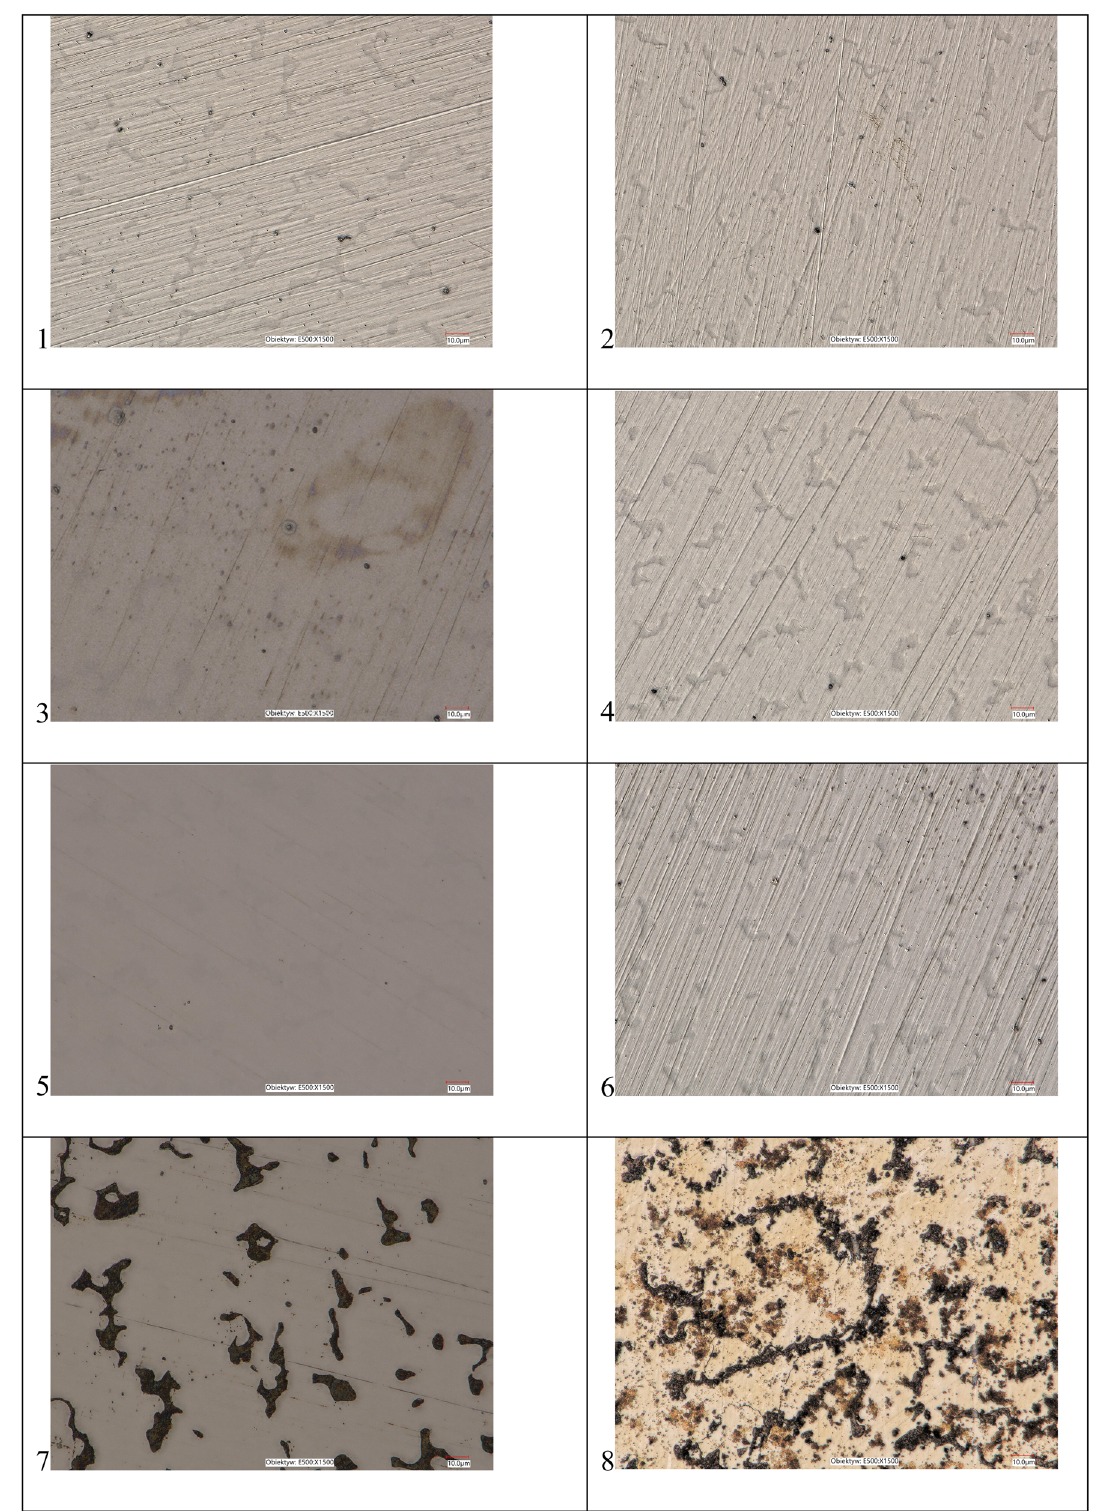
Figure 1: Digital microscopy images of Co – Cr alloy after storage: ( 1 ) dry, ( 2 ) in water, ( 3 ) 20% sodium percarbonate, ( 4 ) 20% chlorhexidine digluconate, ( 5 ) Corega Tabs Bio Formula, ( 6 ) 20% citric acid, ( 7 ) 0.5% NaOCl, and ( 8 ) 5.0% NaOCl. Magni fi cation 1,500 ×